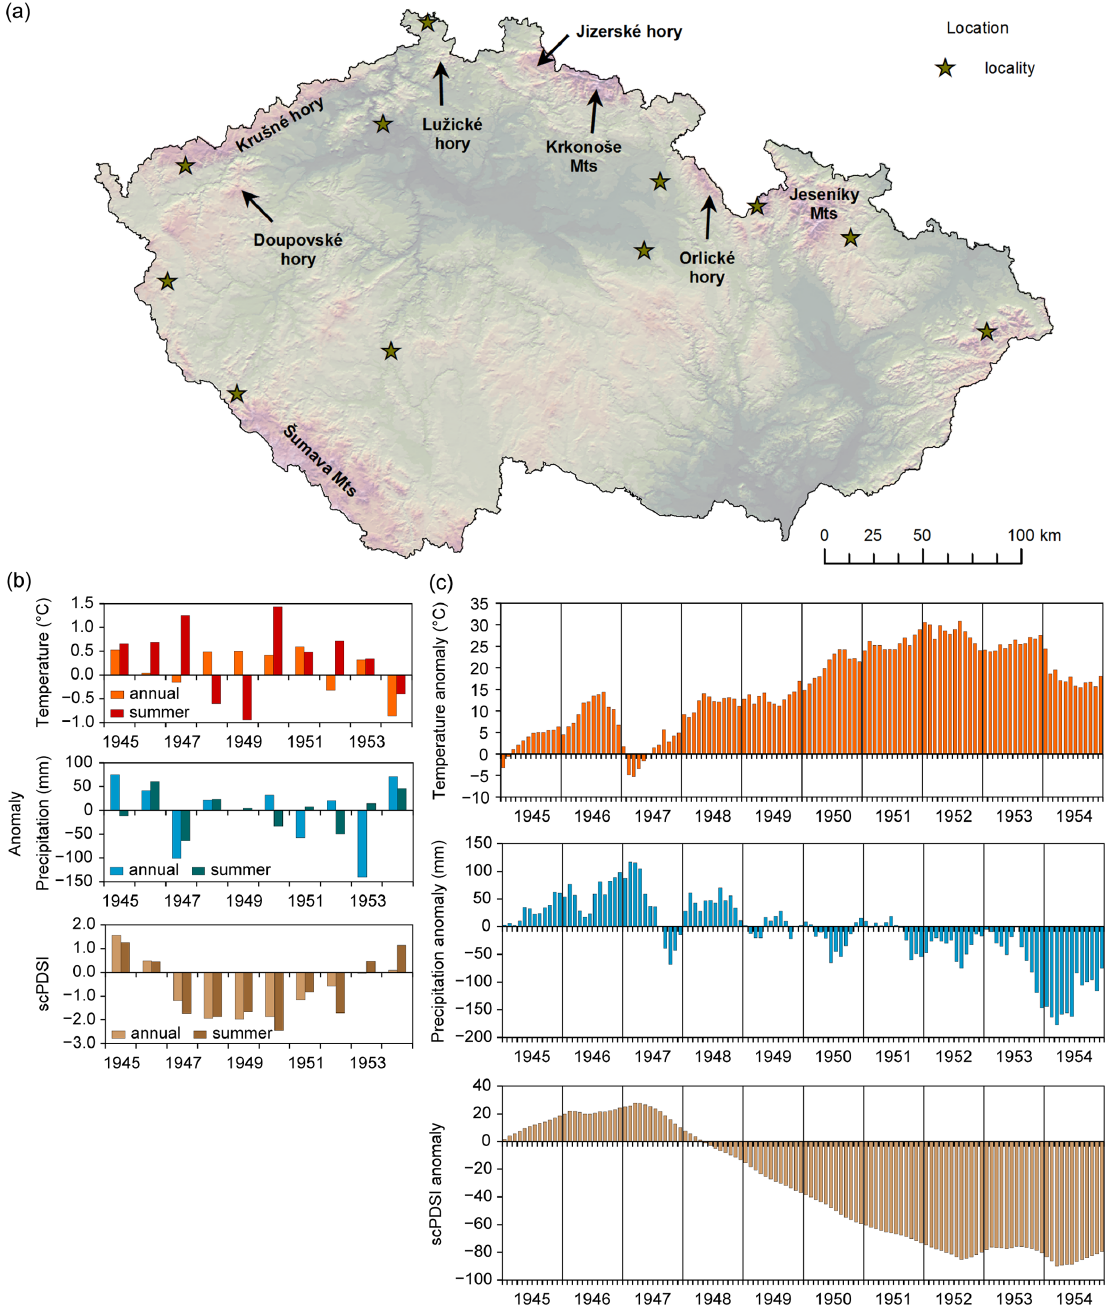
Figure 6. Bark beetle outbreak of the 1940s–1950s on the territory of the Czech Republic: (a) location of regions and localities with the occurrence of bark beetle; (b) annual and summer anomalies of temperature, precipitation, scPDSI-12, and scPDSI-3 in 1945–1954; (c) cumulative monthly anomalies of temperature, precipitation, and scPDSI in 1945–1954 (1961–1990 reference period).